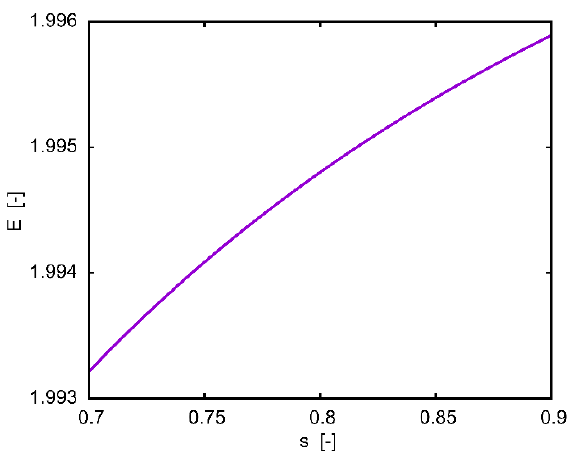
Figure 5. Parameter 𝐸 vs. span-wise load factor 𝑠 , for WV core radius 𝑟 𝑐 = 5.2% 𝑏 0 , as in [43].